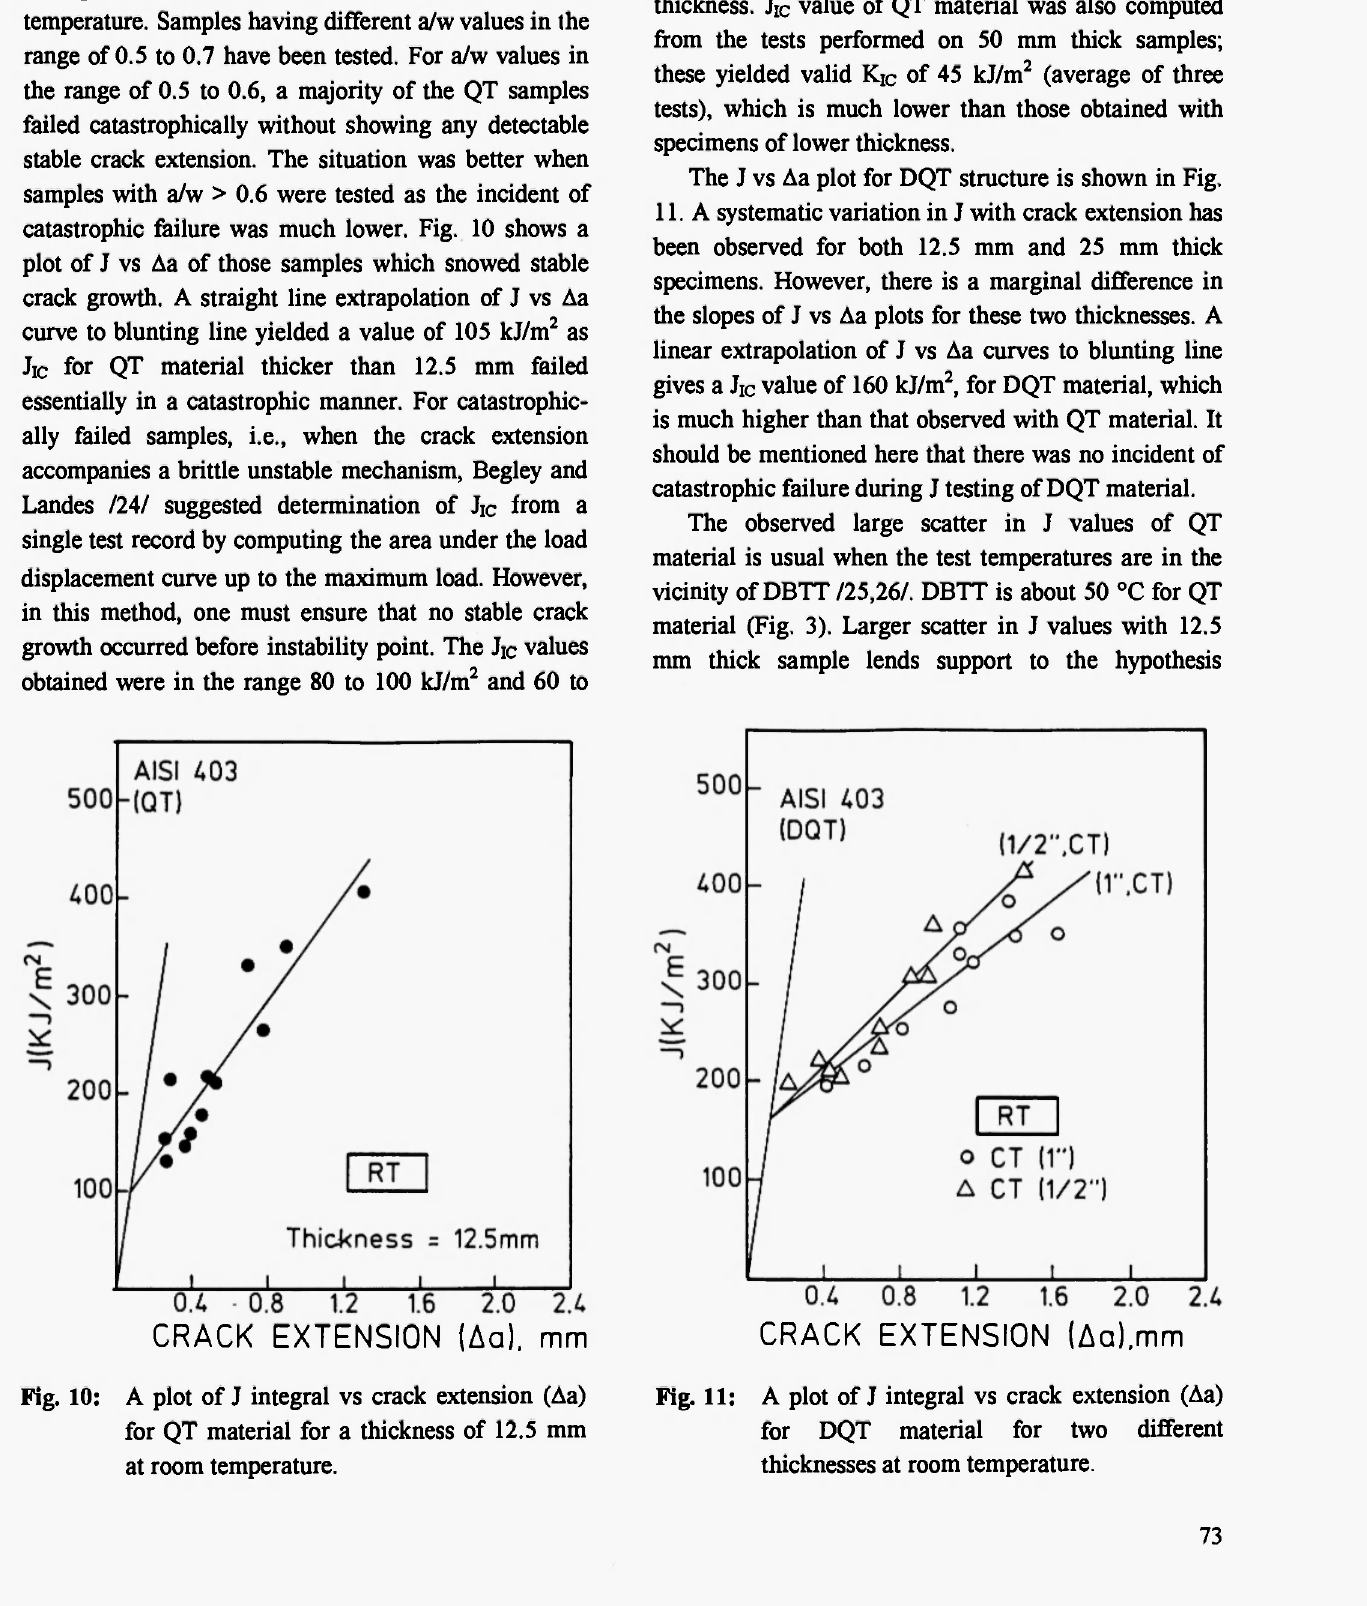
Fig. 10: A plot of J integral vs crack extension (Aa) for QT material for a thickness of 12.5 mm at room temperature.